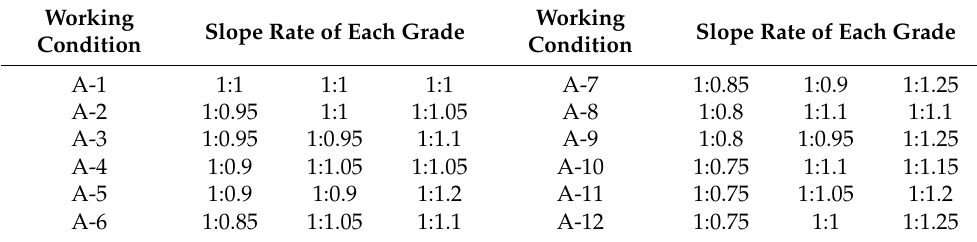
Table 1. Each grade of multi-stage loess slope changes the calculation